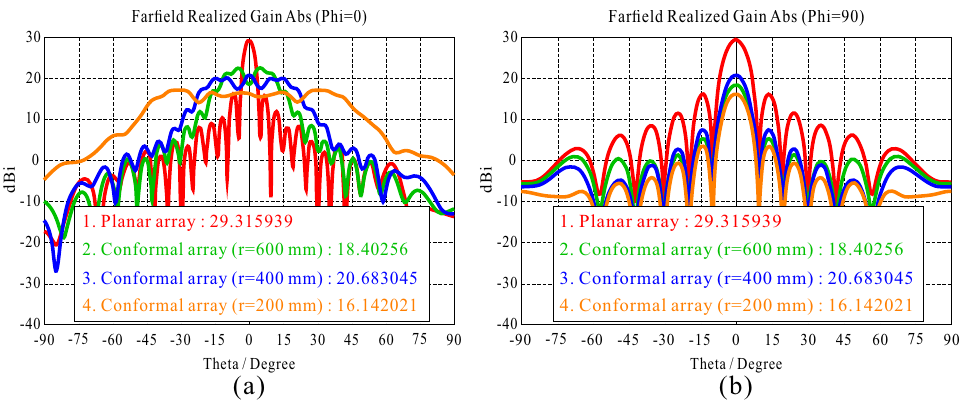
Figure 3. Comparison of 2D radiation patterns of 12 × 24 planar and conformal arrays: ( a ) φ = 0 ◦ plane and ( b ) φ = 90 ◦ plane.